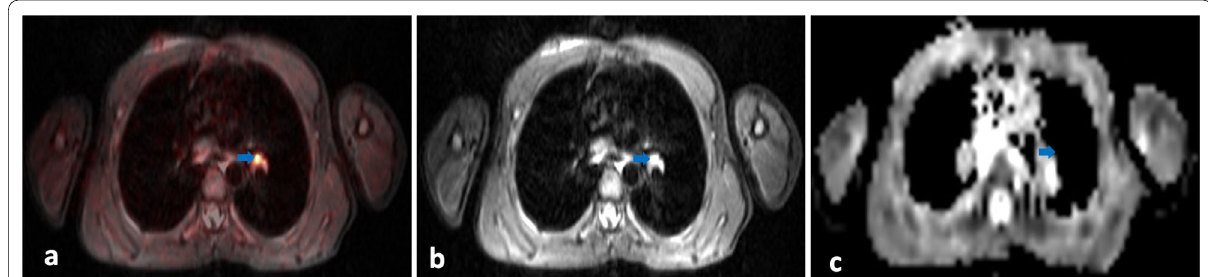
Fig. 3 a – c [ 18 F]‑FDG‑PET/MR image ( a ), T2‑TIRM image ( b ) and DWI ( c ) of the thorax. The left hilar lymph node (blue arrow) has increased glucose metabolism (SUV max 3.3) ( a ) but is small (0.9 0.7 cm) ( b ) and without diffusion restriction (ADC: 3800 ×